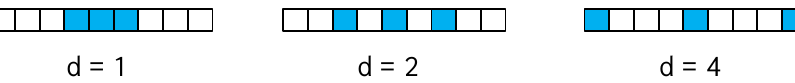
Figure 4. Visualization of 1D convolutions with different dilation factors.